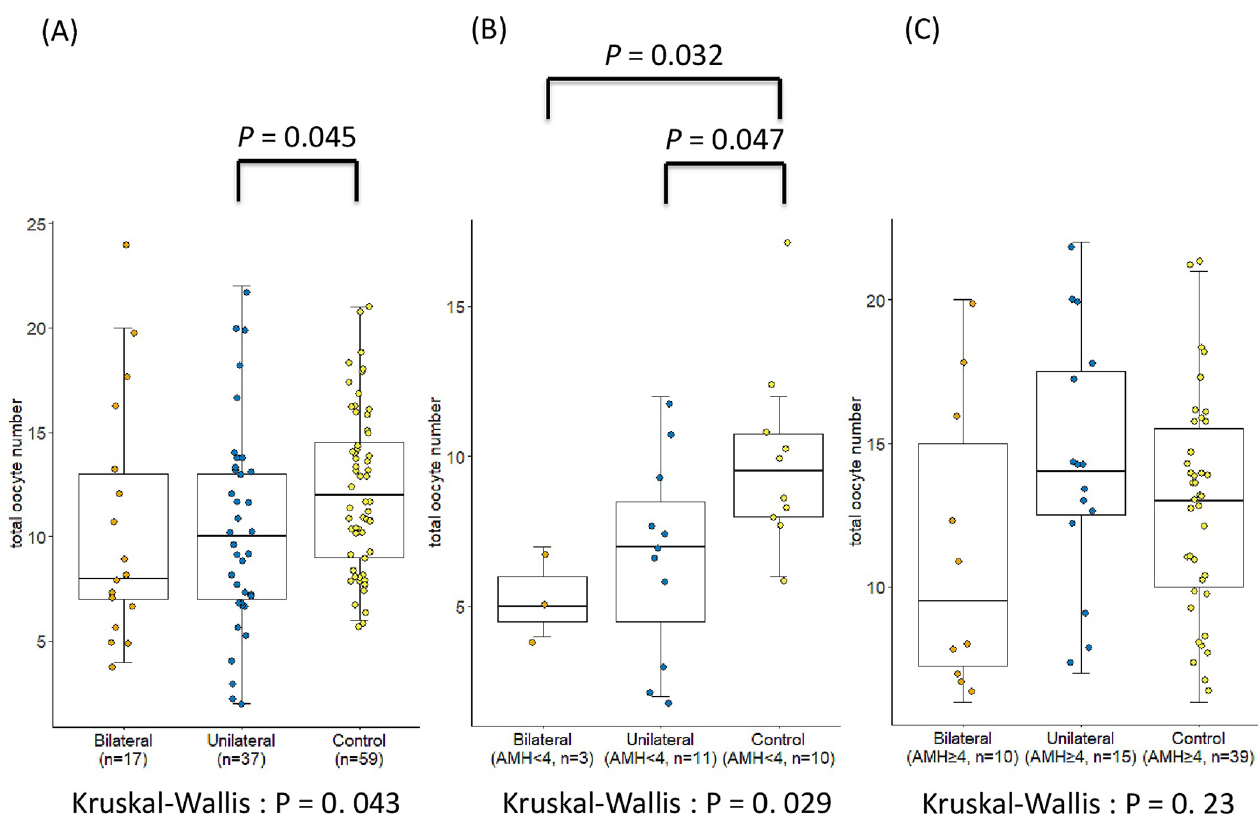
Fig 3. Total numbers of retrieved oocytes in those with bilateral, unilateral, and without salpingectomy histories. Differences in the retrieved oocyte numbers in women with bilateral salpingectomy, unilateral salpingectomy, and without salpingectomy (A) in all enrolled subjects, (B) in women with AMH < 4 ng/mL, and (C) in women with AMH � 4 ng/mL. AMH: anti-Mu¨llerian